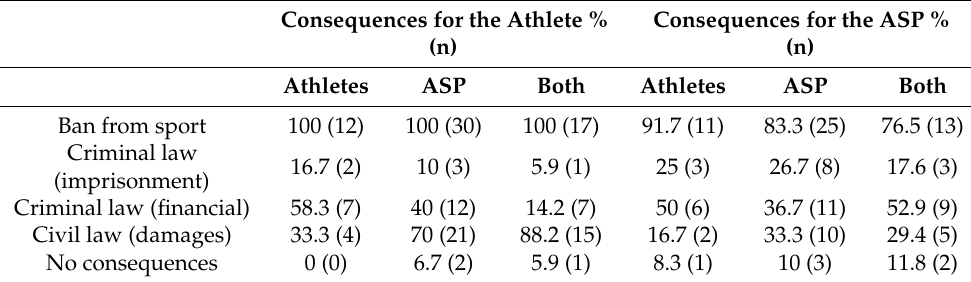
Table 1. Consequences for ADRVs presented in the case